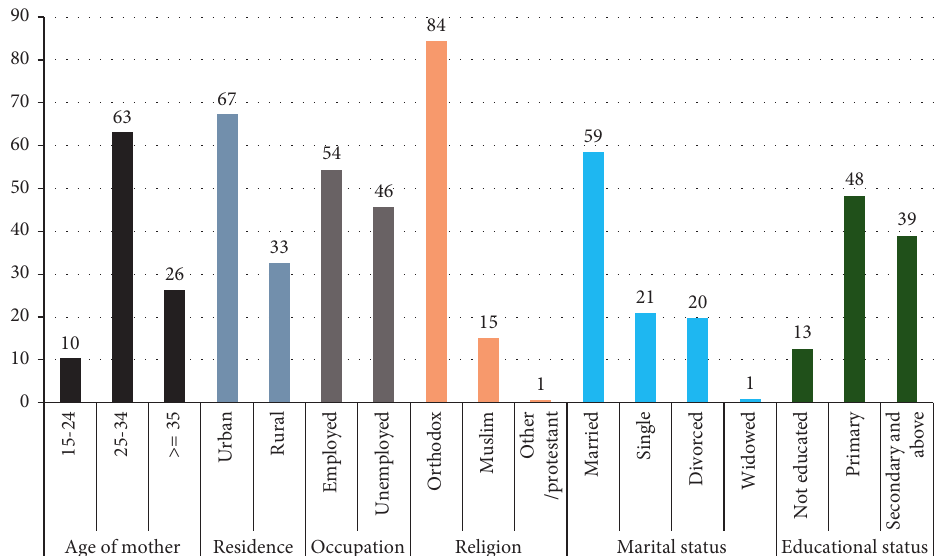
Figure 1: Sociodemographic characteristics of mothers enrolled in PMTCT care in selected public general hospitals of West Guji zone, Ethiopia, from March 2019 to March